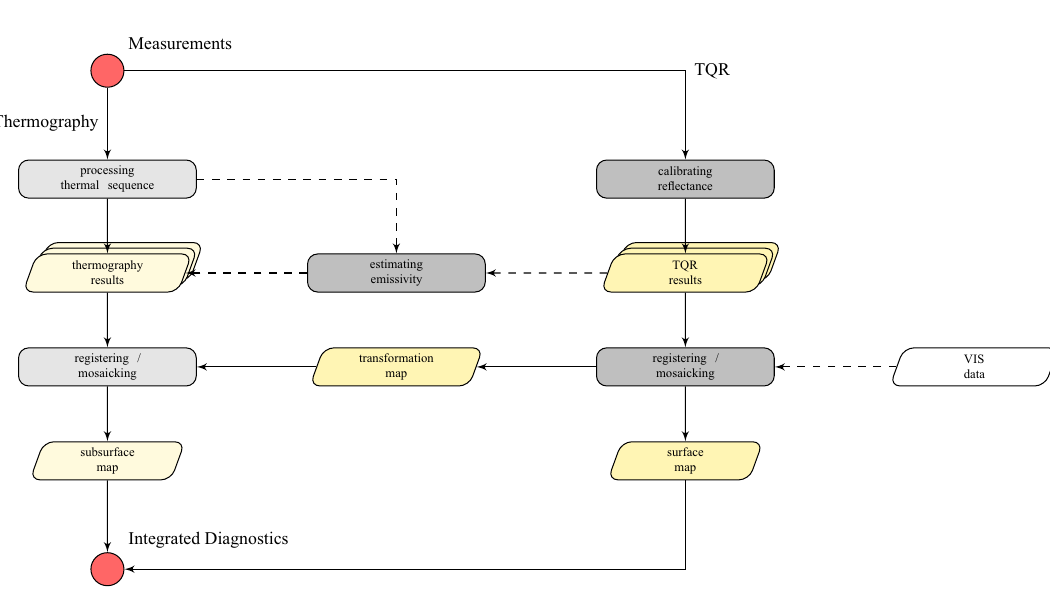
Figure 8. Workflow of MWIR dual mode imaging